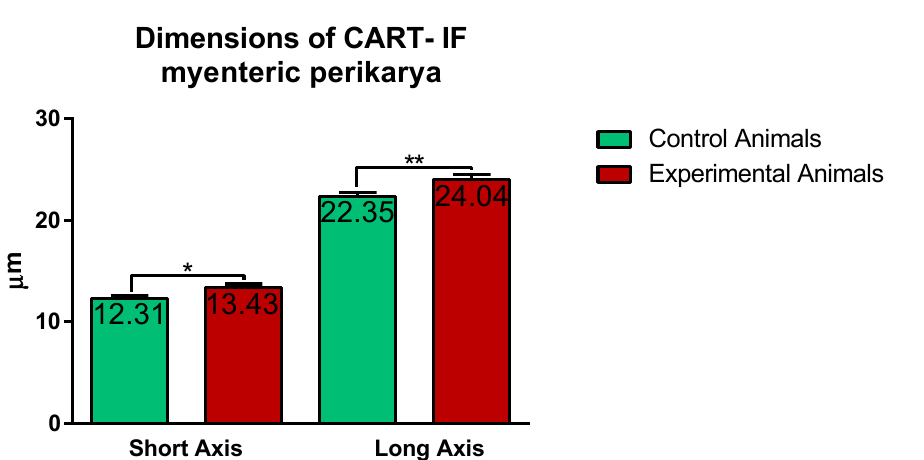
Figure 5. Graph showing the average dimensions (long and short axis) of myenteric perikarya in the control and experimental animals. Both dimensions were increased in ulcer animals. (*) p value = 0.0226; (**) p value = 0.0044.